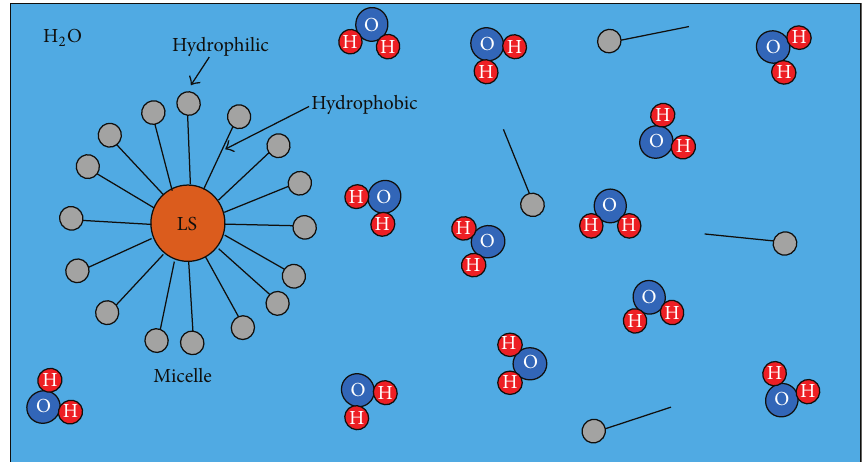
Figure 1: Structure of surfactant and micelle in a LS. Surfactant is a material having hydrophilic group and hydrophobic (or lipophilic) group. Surfactant molecules organize to form micelles. It helps dissolve LS in water.